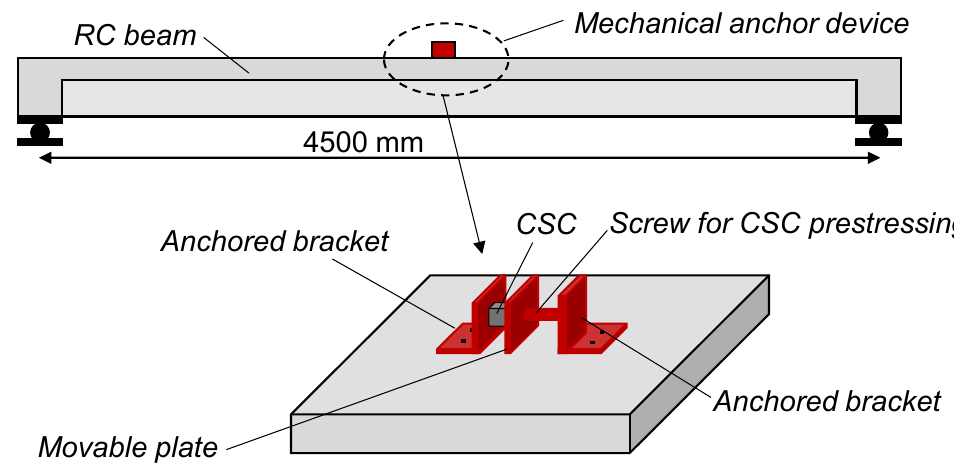
Figure 9. Externally mounted CSC sensors on a RC beam (adapted from [54]).